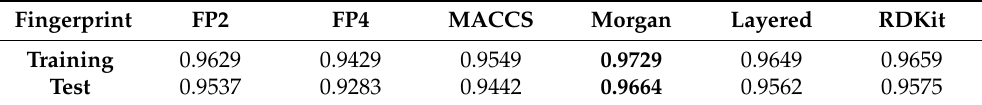
Table 1. The ODDT training and test set modeling metrics.